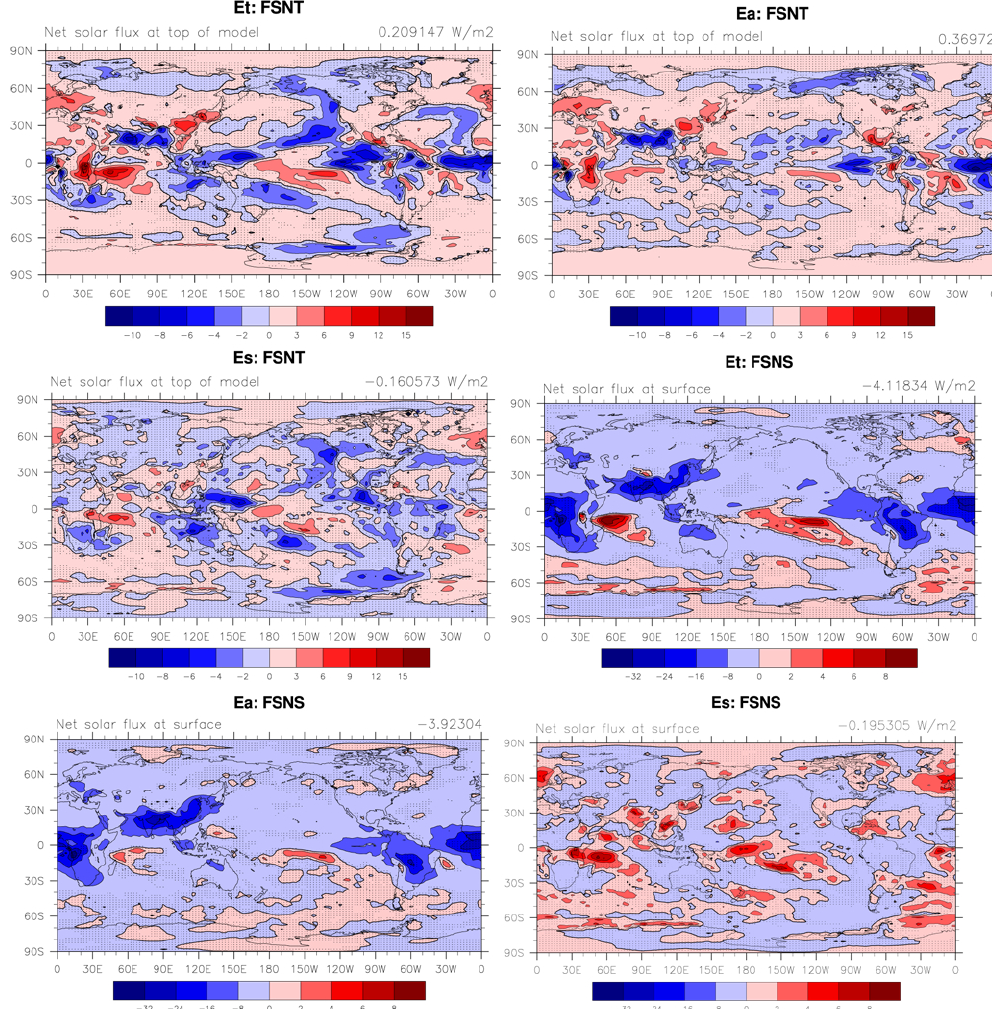
Fig. 11. Changes in annual mean all-sky shortwave radiative flux at the top of model and the surface for Et, Ea, and Es. The numbers at the right corner represent the global mean